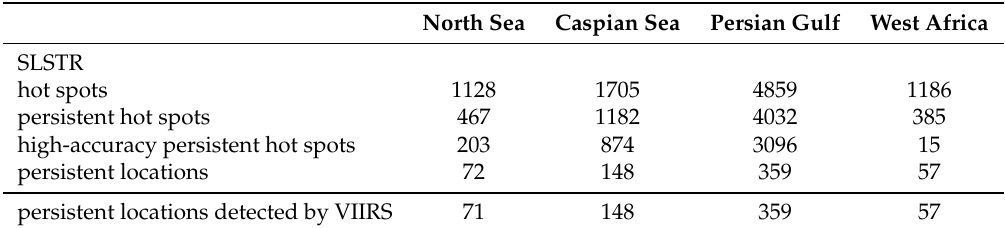
Table 3. Summary of the detections based on SLSTR and spatial comparison with VIIRS